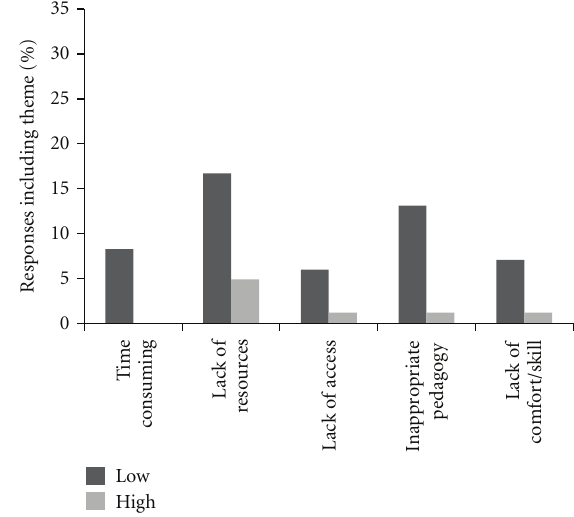
Figure 2: Patterns of themes by integration level for not supporting the concept of integrating computer technology for